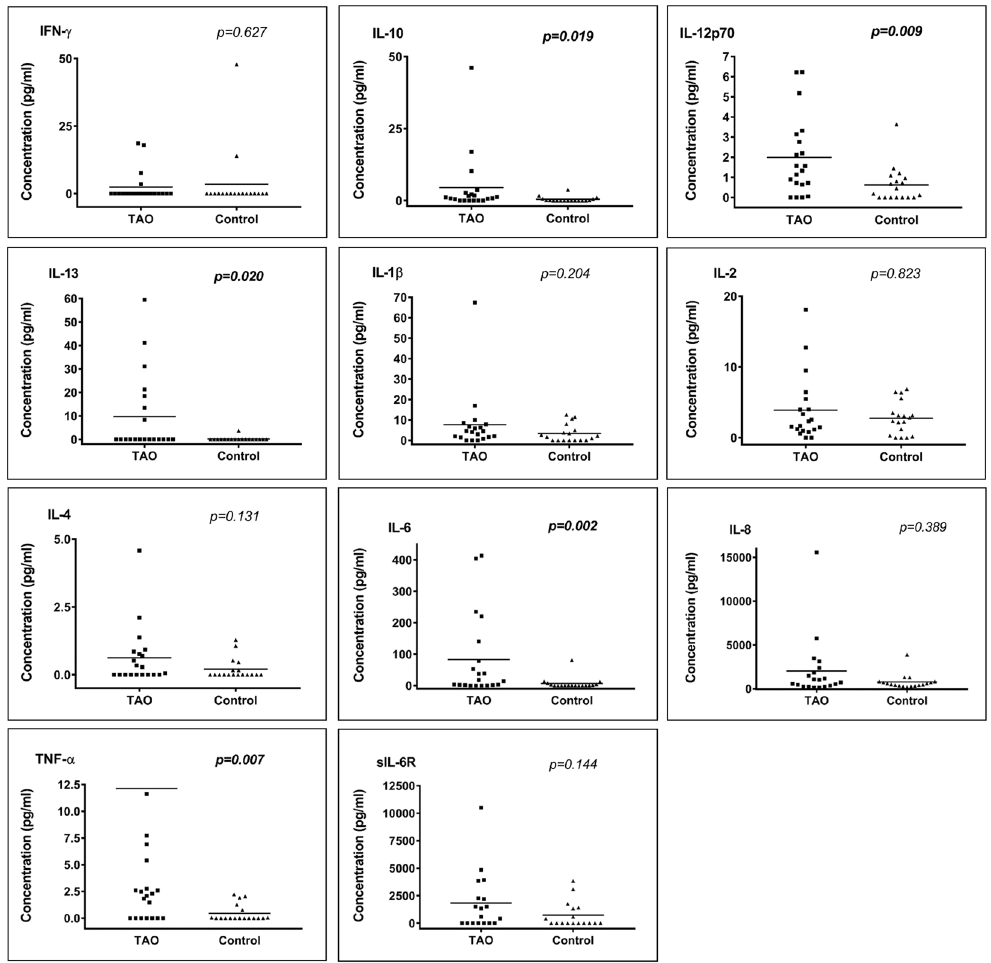
Figure 1. Cytokine concentrations in tears of TAO patients versus those of control patients (pg/ml). * Mann- Whitney U tests, p-values (bold data highlight significant p-values). For esthetical reason, the point of one TAO patient was removed for TNF- α , as he had a concentration much higher than the other patients (193.20